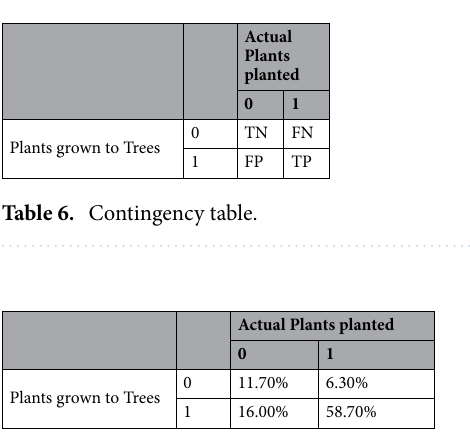
Table 7. Contingency table for tire-water-box.